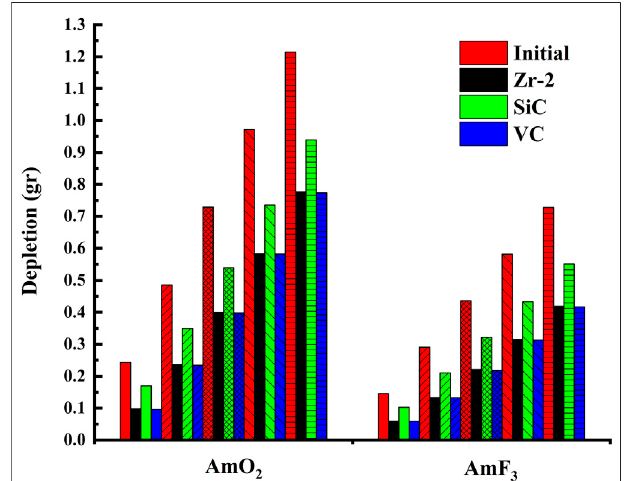
FIGURE 7 | The contribution of each zone to the heating for Zr-2, SiC, and VC clads, the fuel components AmO 2 and AmF 3 ( 0.02%, 0.04%, 0.06%, 0.08%,0.1%) in the BWR system.